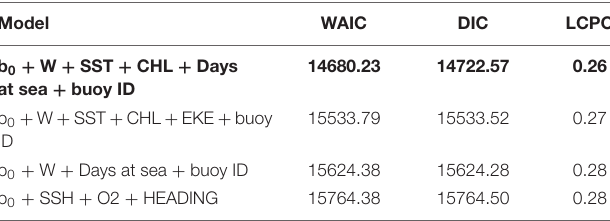
TABLE 4 | Comparison of the most relevant models for the non-tunas B-HSMs.